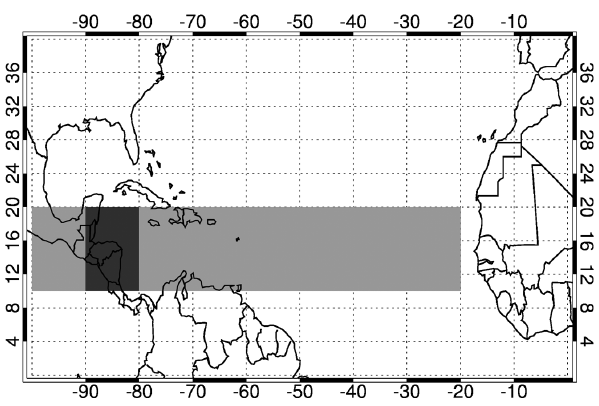
Fig. 1. Dust barrier-averaging regions (shaded).